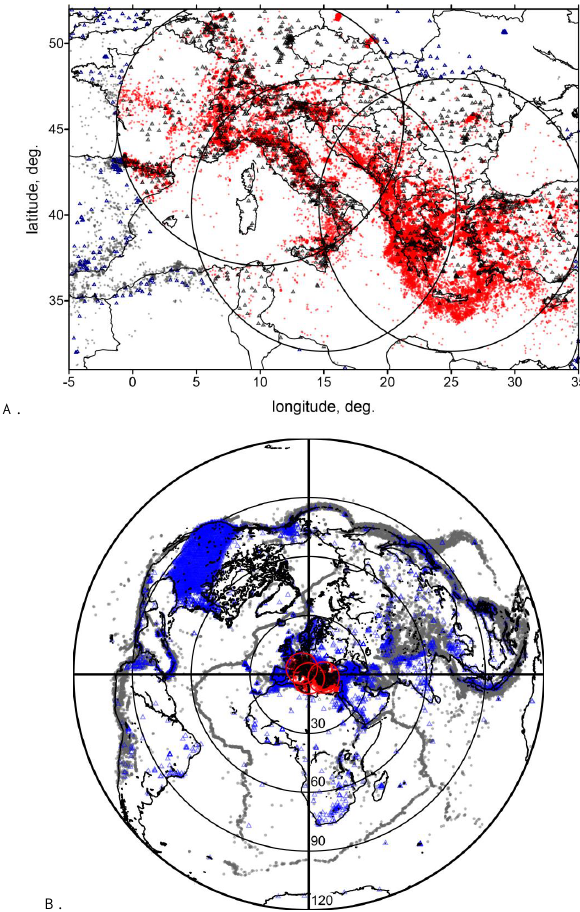
Figure 2. Distribution of data used for tomography in the study re- gion (a) and globally (b) . Circles indicate the target areas where the inversions were performed. Black and blue triangles denote stations inside and outside the target circles, respectively. Red and gray dots are the events inside and outside target circles,